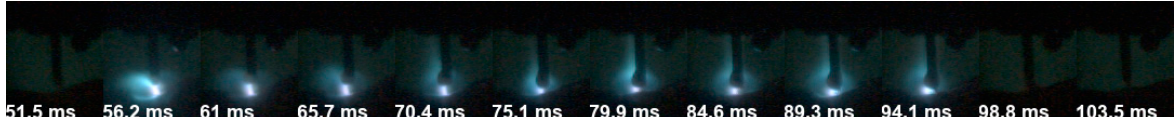
Figure 6. CSC cycle, time correlates with the waveforms in Figure 5.